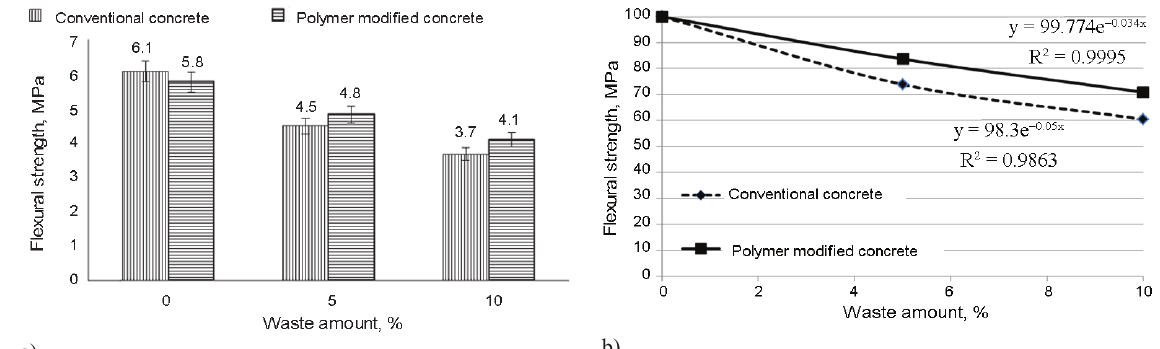
Fig. 5. influence of the amount of ecW on the flexural strength of concrete samples in MPa (a) and in %